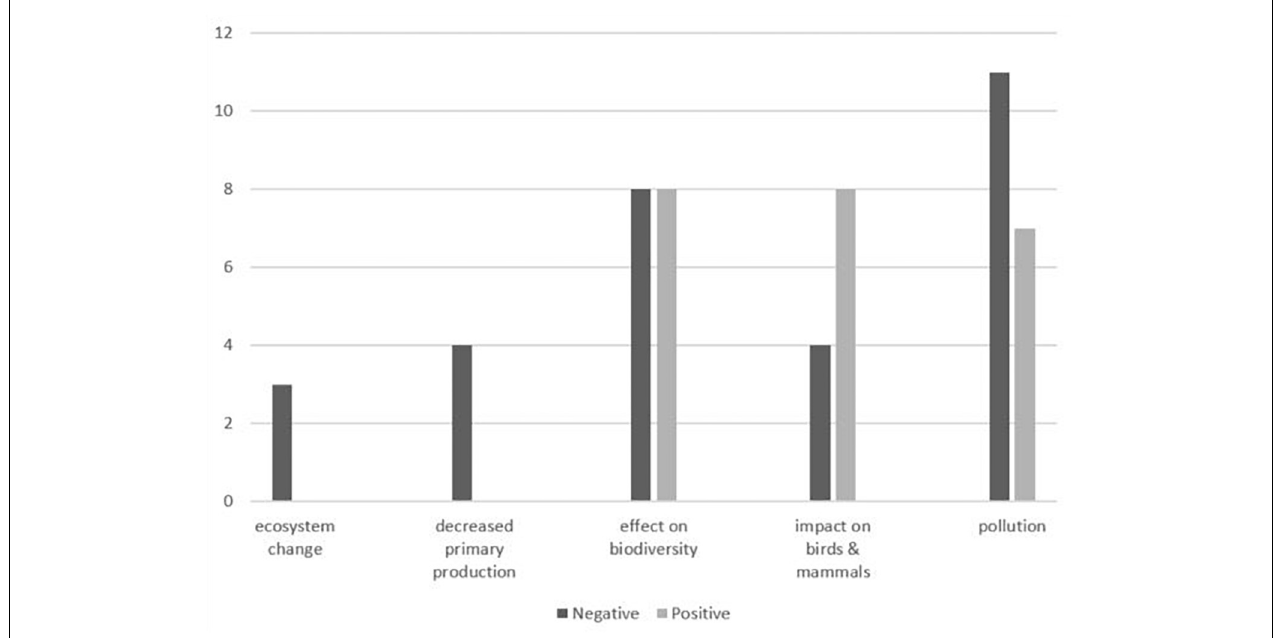
FIGURE 1 | Environmentral risk of concern according to respondents.